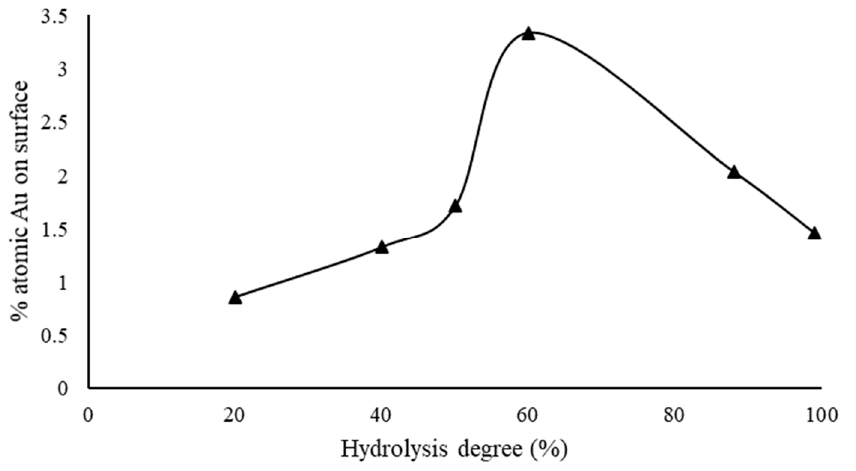
Figure 1. Percentage of atomic Au on the surface versus polyvinyl alcohol hydrolysis degree. Table 5. X-ray photoelectron spectroscopy (XPS) data for 1% wt. Au/AC synthesized using PVA-2 (M n = 13,000–23,000) with different hydrolysis degrees.